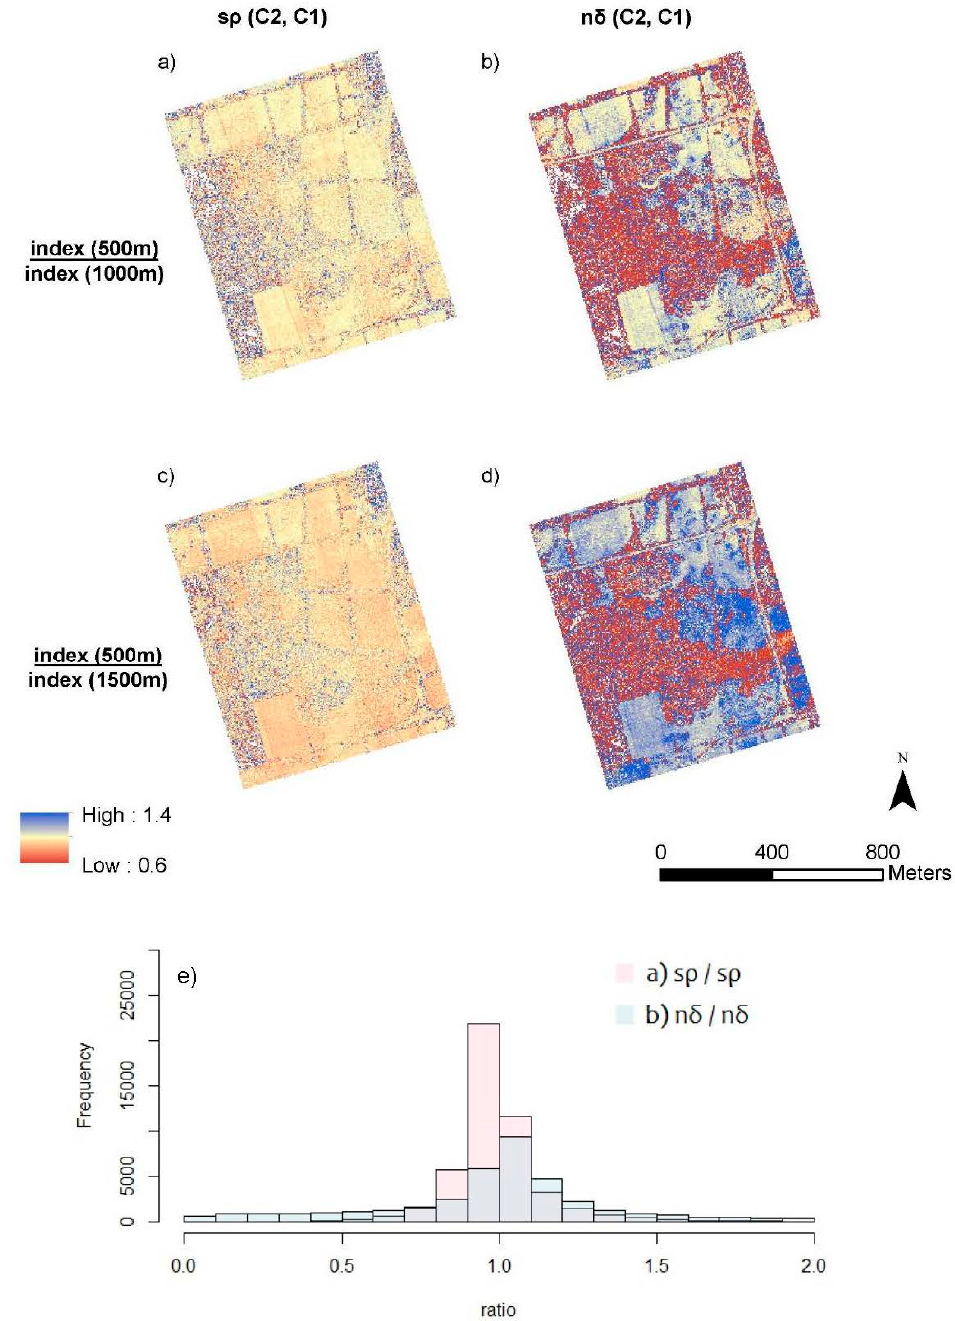
Figure 10. Ratios derived from single return indices at 4 m × 4 m grid: ( a ) ratio of s ρ (C2, C1) at 500 m to s ρ (C2, C1) at 1000 m; ( b ) ratio of n δ (C2, C1) at 500 m to n δ (C2, C1) at 1000 m; ( c ) Ratios of s ρ (C2, C1) at 500 m to s ρ (C2, C1) at 1500 m; (d) ratio of n δ (C2, C1) at 500 m to n δ (C2, C1) at 1500 m. ( e ) histograms for Figure 10a,b. White pixels represent no data.